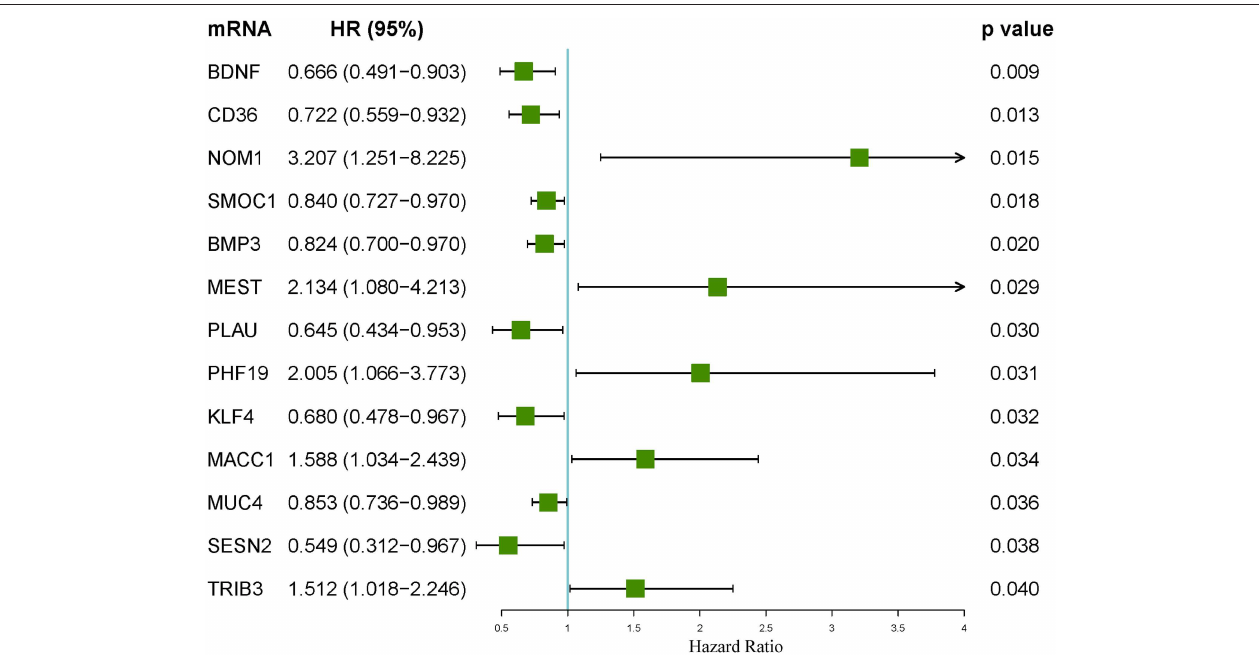
FIGURE 9 | Forest plot of the hazard ratios of the mRNAs included in the competing endogenous RNA (ceRNA) network. A hazard ratio > 1 indicates the high-risk mRNAs, and a hazard ratio < 1 indicates the protective